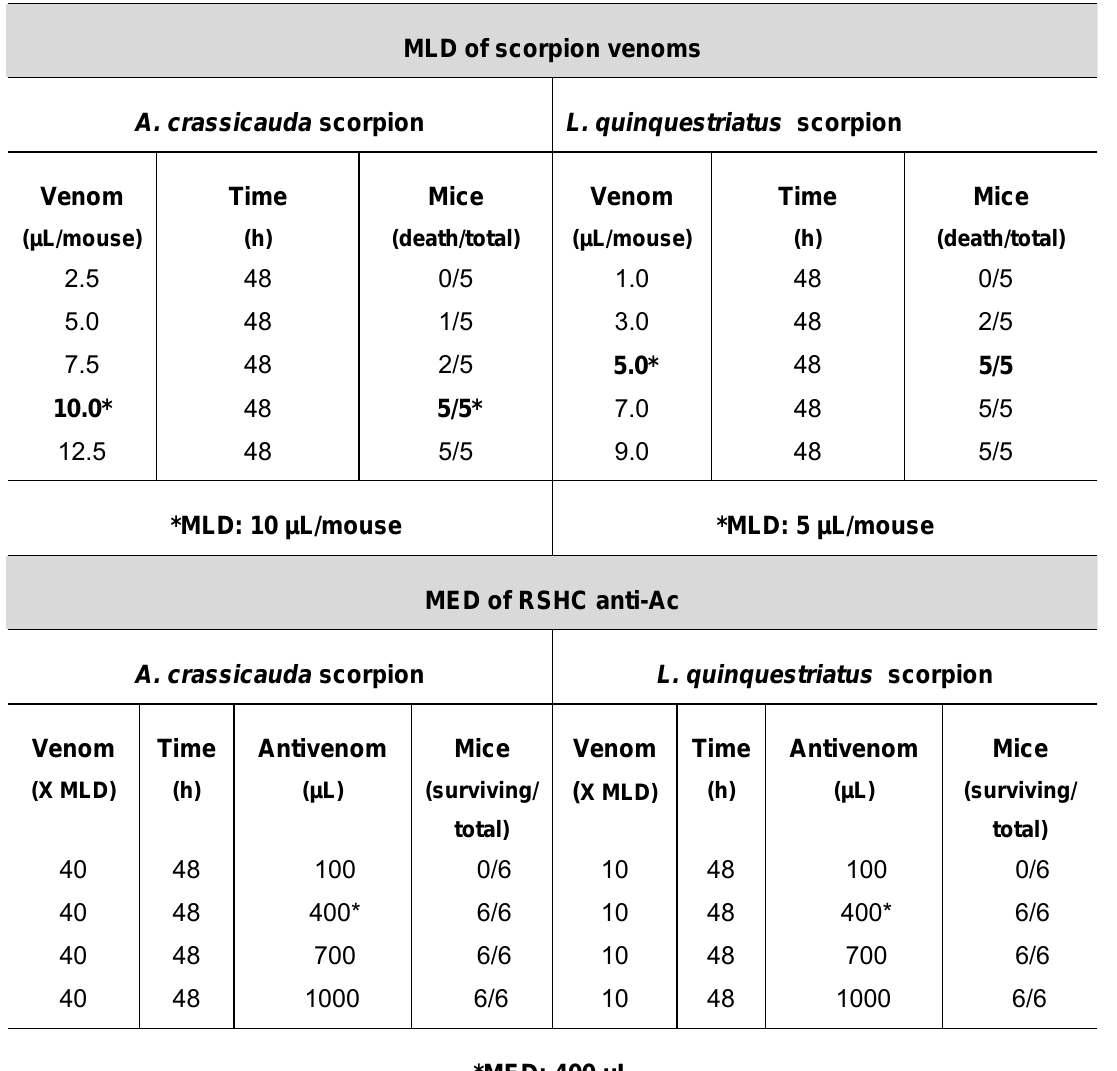
Table 1. The MLD was determined for L. quinquestriatus and A. crassicauda venoms by SC injection. Neutralization capacity of antivenom was assayed for both venoms in